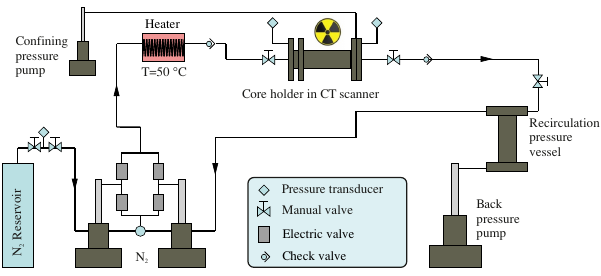
Figure 2. Schematic setup of the core-flooding apparatus for single- phase (N 2 ) flow experiments (after Huo and Benson,